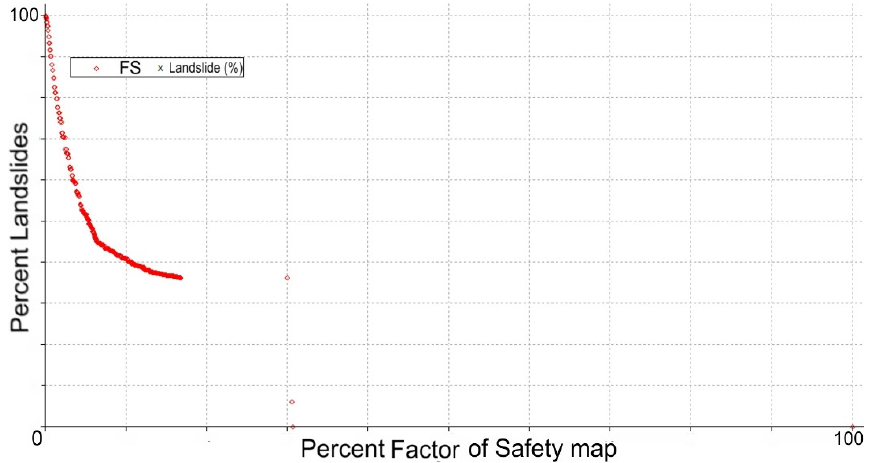
Figure 8. The prediction-rate curve representing the cumulative percentage of triggered landslide correctly classified in each stability class on the y -axis (true positive rate), and the percentage of area classified as positive (i.e., unstable and critical units classified as positive) on the x -axis, ranked from most (SF < 1) to least susceptible (SF > 1).